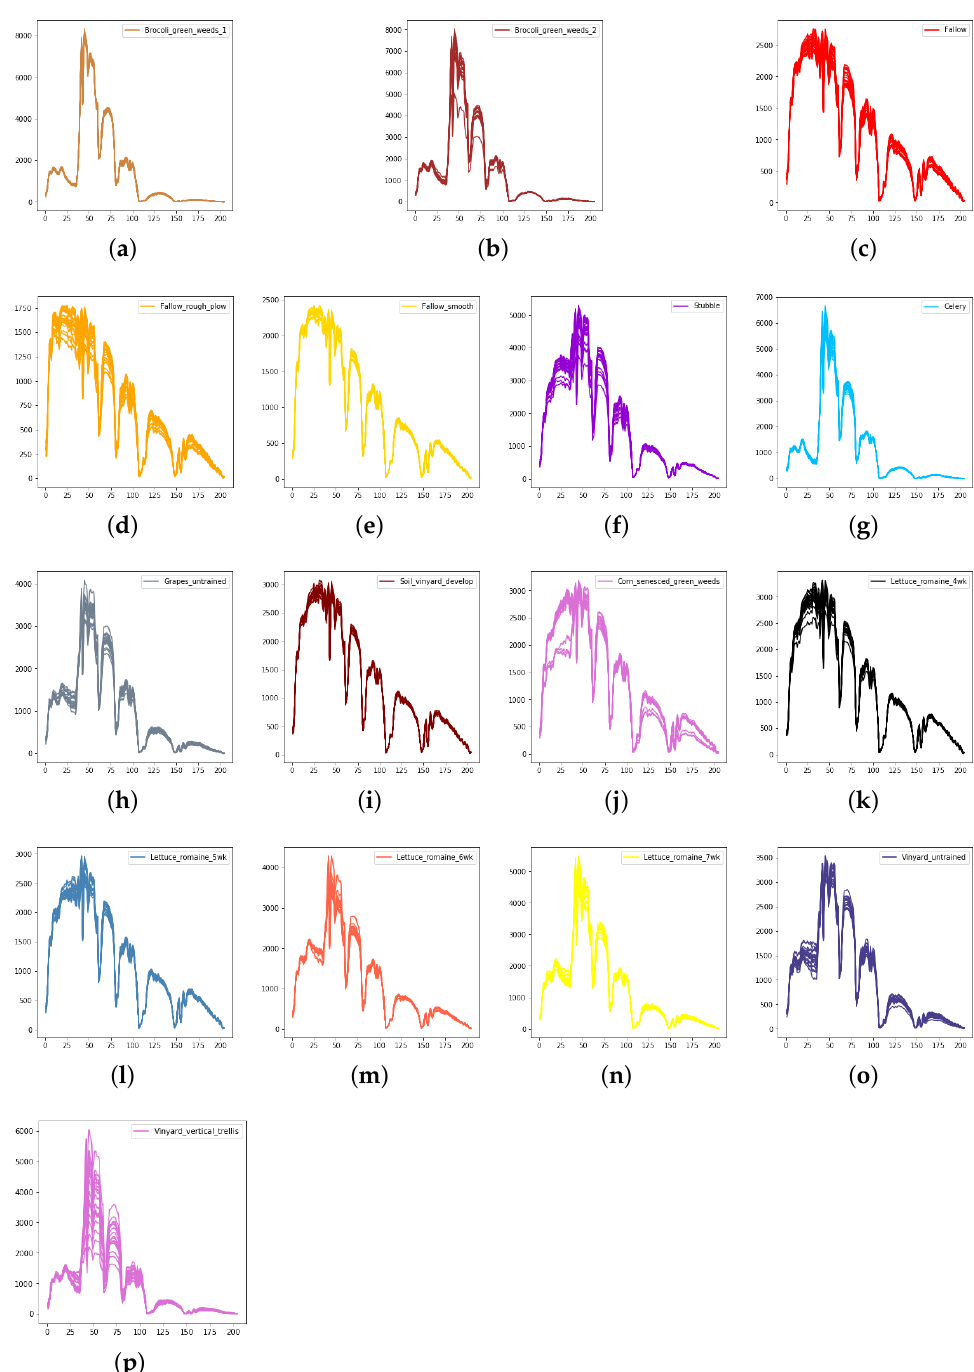
Figure 10. The spectral radiance of different pixels and the corresponding categories in